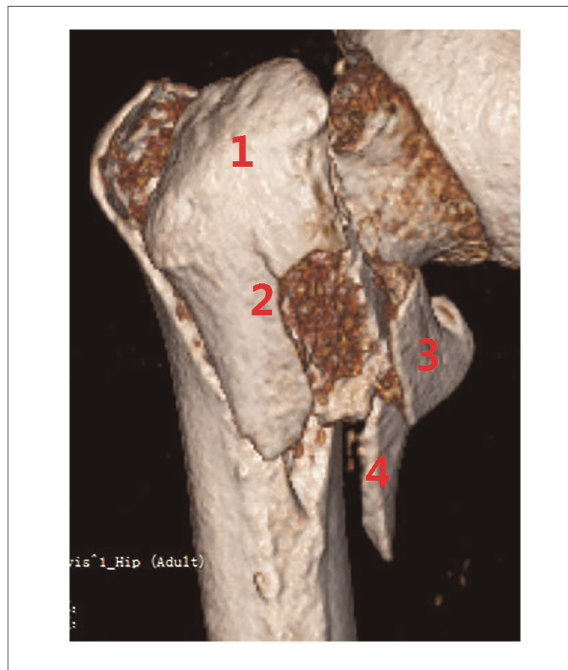
FIGURE 9 Subtype A2.3, with comminuted posterior coronal fragments ( n ≥ 2). (1) Posterior greater trochanter, (2) the crest, (3) lesser trochanter, and (4) posteromedial cortex.